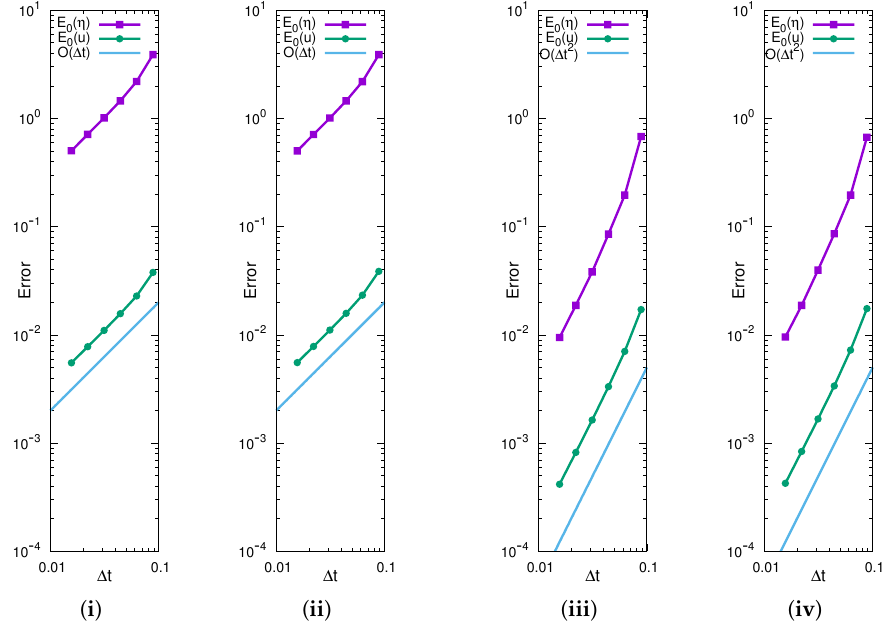
Figure 4. Graphs of errors E 0 ( η ) and E 0 ( u ) in logarithmic scale by LG1 for Example 1 ( i )